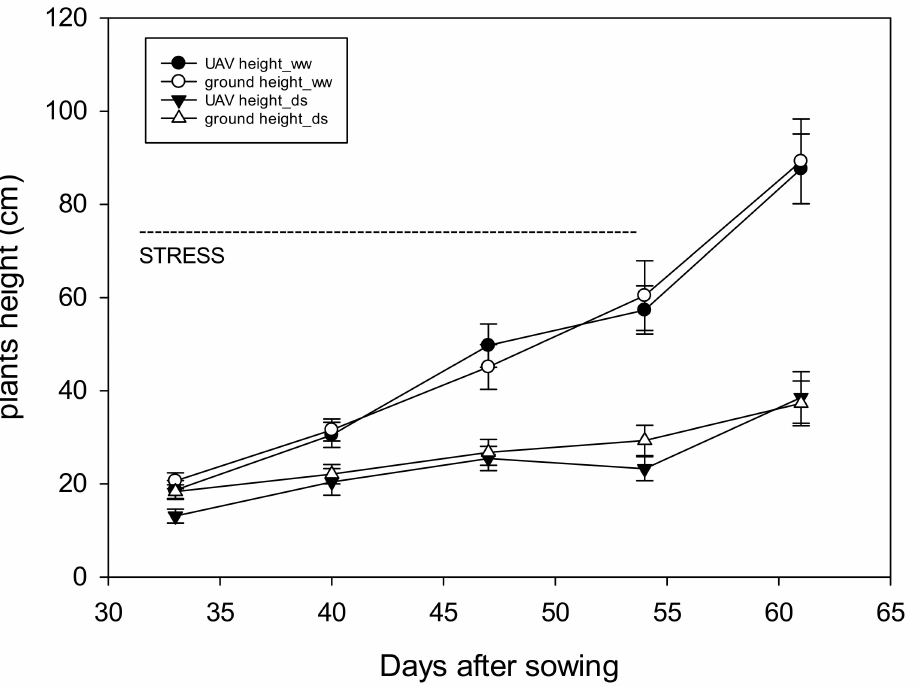
Figure 7. Dynamics of UAV and ground-based plant height in well-watered (ww) and drought stress (ds) treatments in 2018 field trial. Each point is the average of the 10 studied sorghum varieties with standard error. Table 5. ANOVA of the vegetation indices of varieties under well-watered and drought